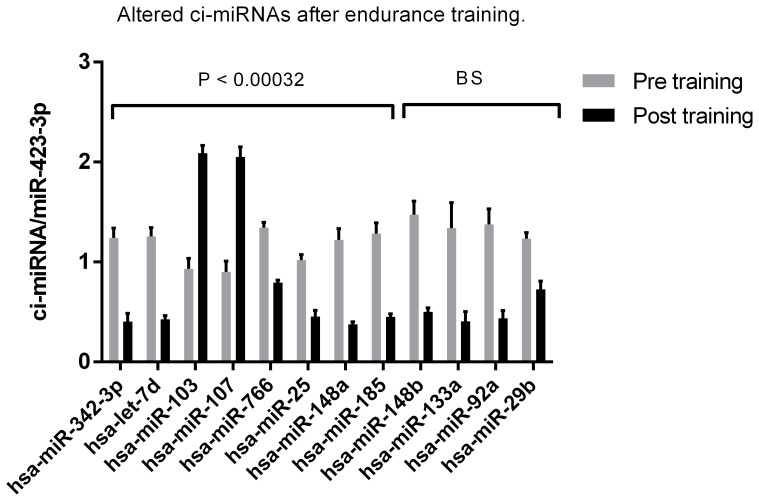
Alterations in ci-miRNAs in plasma in response to 12 weeks of endurance training.Two ci-miRNAs were up regulated and seven were down regulated in response to 12 weeks endurance training when Dunn-bonferroni correction of the significance level 0.05 was performed (P<0.00032). Additional four miRNAs were borderline significant (BS) down regulated at significance level 0.001.